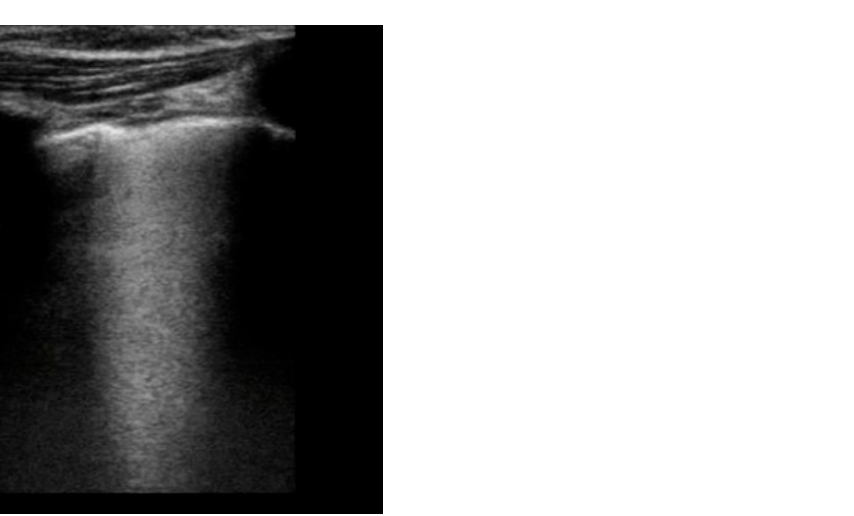
Figure 2. The presence of coalescent B-lines (white lung) associated with the irregular pleural line in the pulmonary parenchyma of a child with COVID-19 infection. The blue point on the left side of the screen, as it is viewed, corresponds to the side of the probe marked with an indicator.